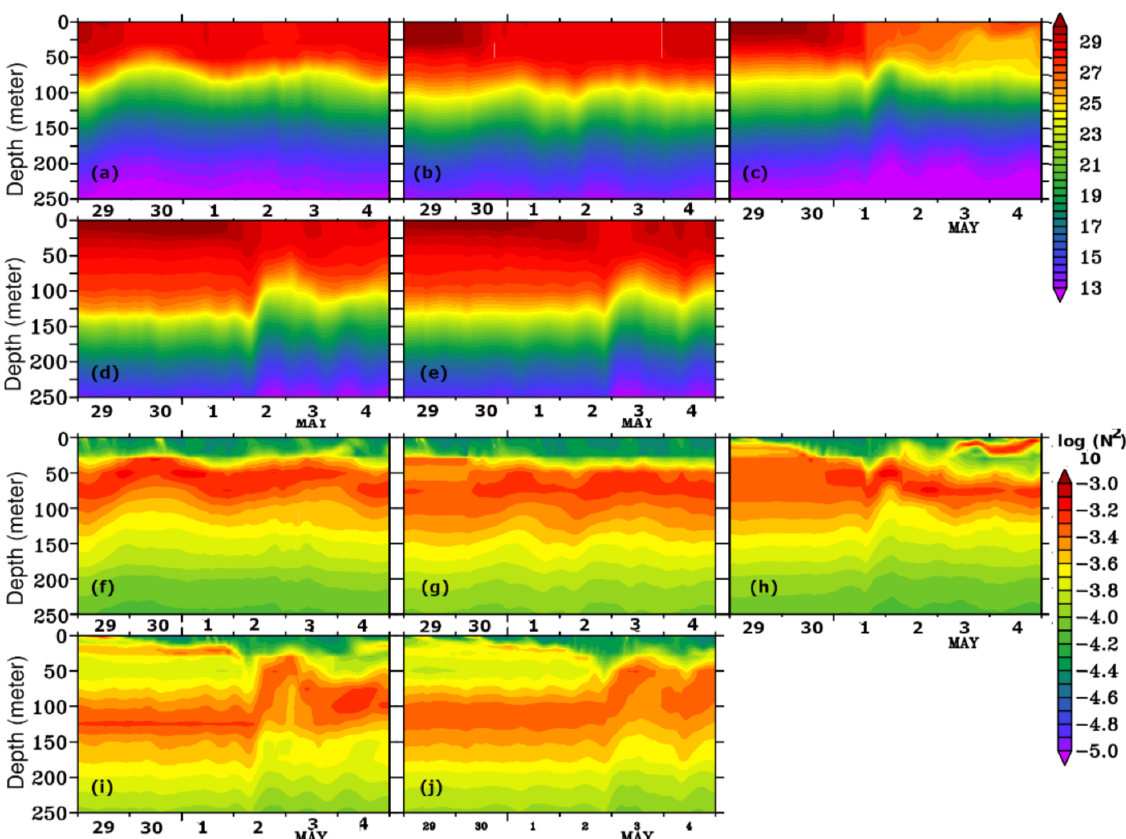
Figure 12. Time series of model-simulated profiles of temperature ( ◦ C) at locations A, B, C, D, E (marked in Figure 7) shown in panels ( a – e ), respectively. Stratification (i.e., buoyancy frequency) computed from model data at points A, B, C, D, E shown in panels ( f – j ),